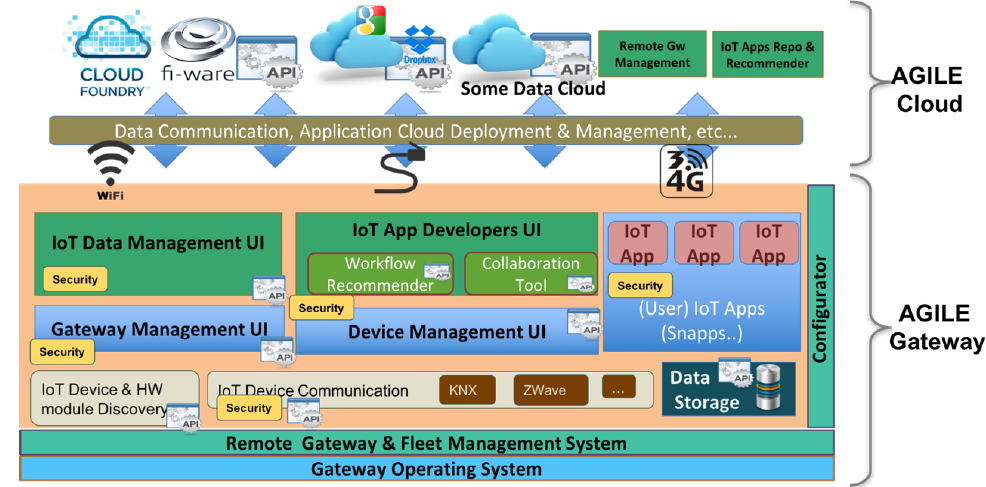
Figure 2. The AGILE modular software